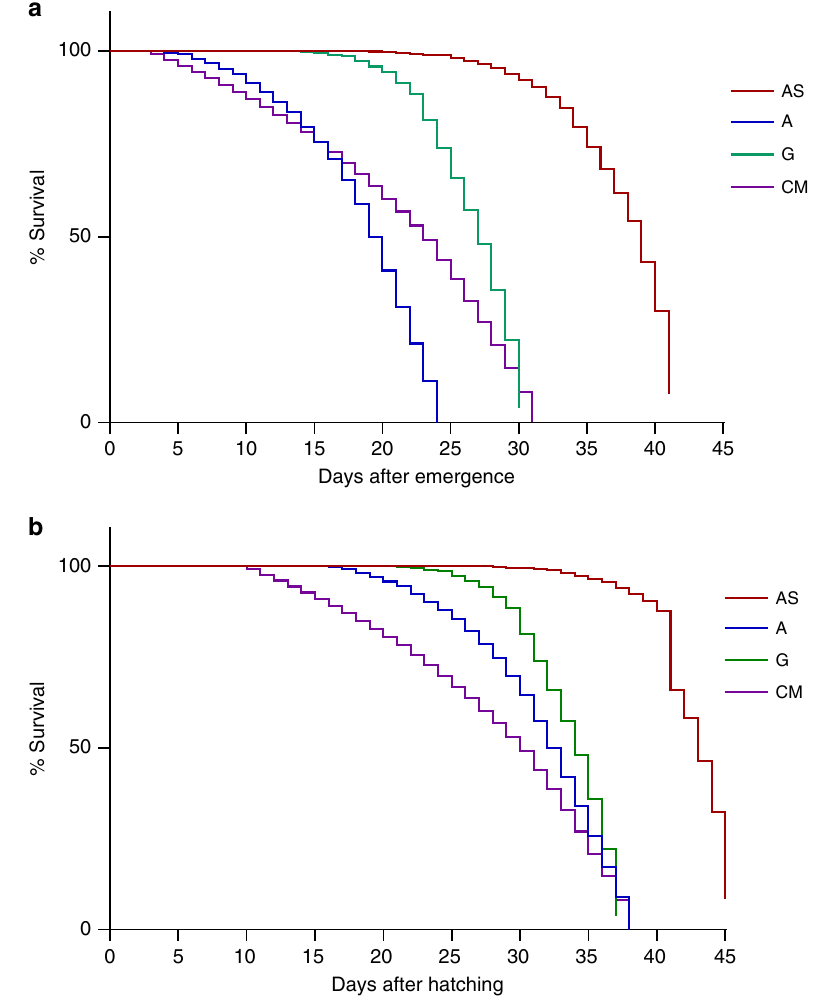
Fig. 5 Mosquito survival curves. a Adult survival as measured days post emergence. b Mosquito survival curve corrected for larval development time. For both a and b , analysis of the Kaplan – Meier survival curves by the Logrank test revealed statistical signi fi cance when all groups were compared together ( P < 0.0001). Sample sizes varied between groups; AS ( n = 23), A ( n = 21), G ( n = 17), and CM ( n = 27). All pairwise comparisons were also signi fi cantly different when compared using the Logrank Mantel – Cox test ( P <